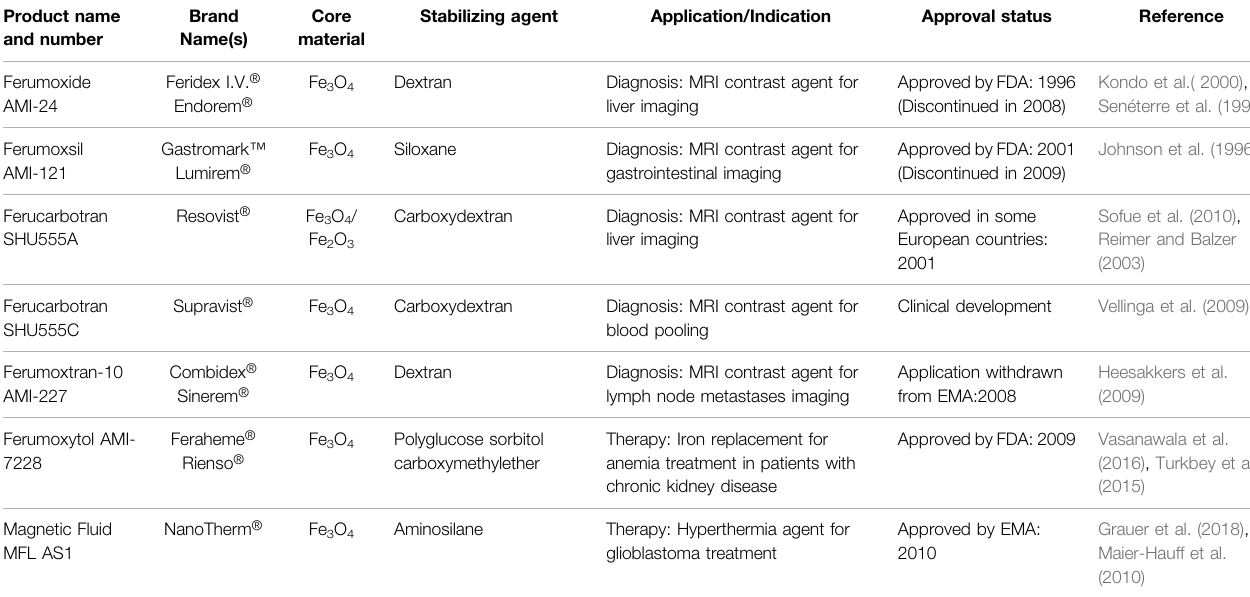
TABLE 2 | List of marketed IO NPs based products, and their application and approval